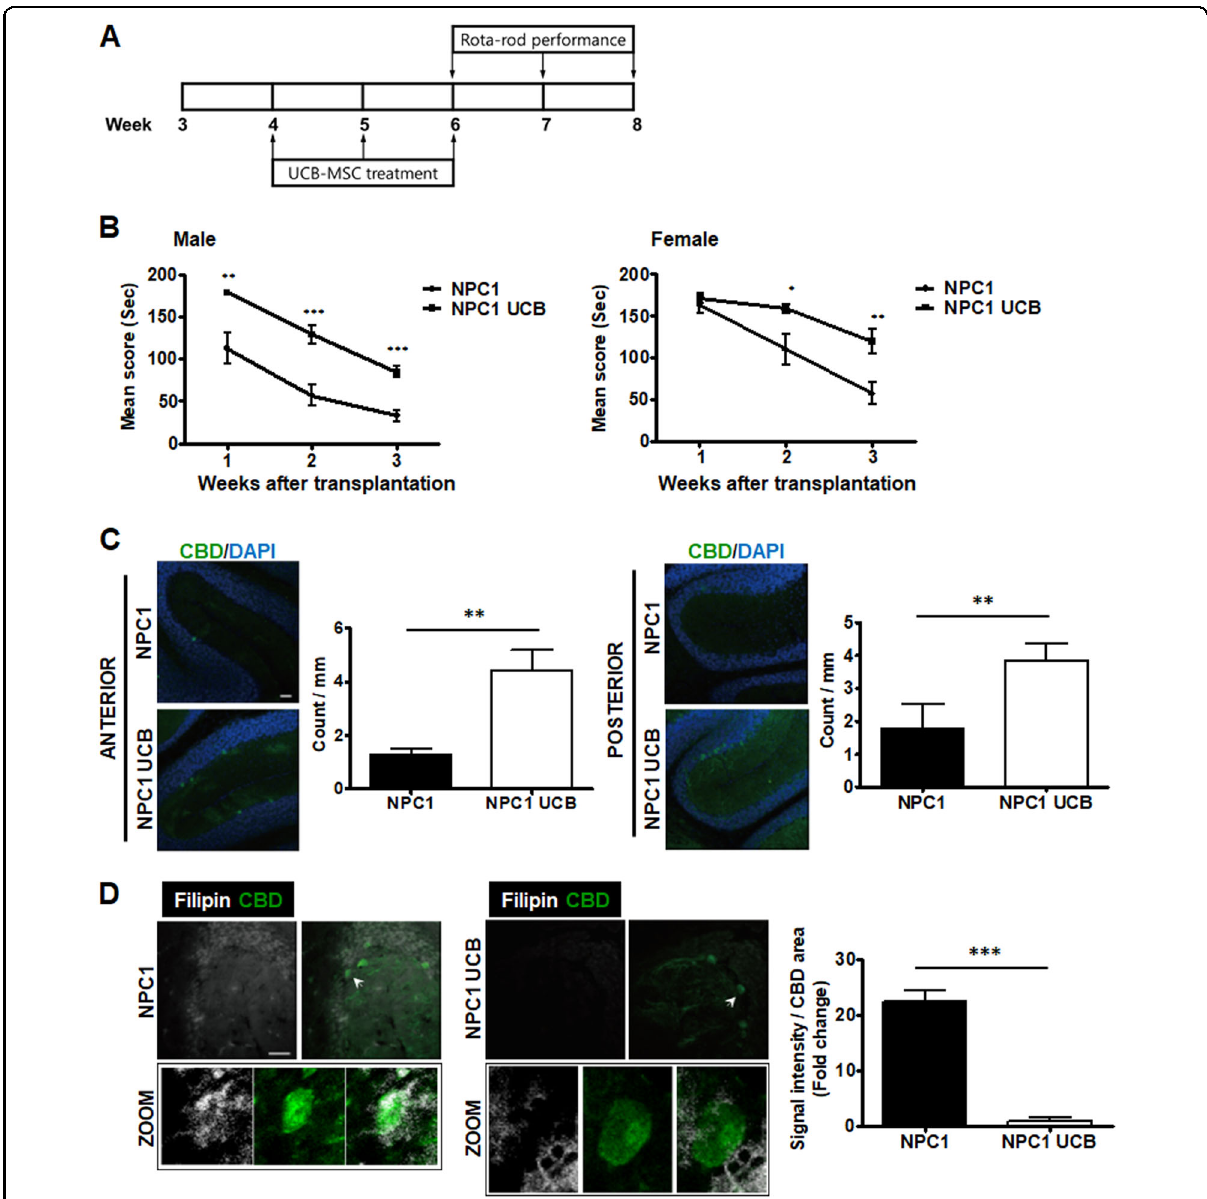
Fig. 2 Motor function and Purkinje cell survival rate in NPC1-mutant mice after intranasal administration of hUCB-MSCs. a Transplantation scheme for intranasal delivery of hUCB-MSCs in NPC1-mutant mice. b Compared with NPC1-mutant mice (NPC1), intranasal delivery of UCB-MSCs (NPC1-UCB) improves performance on the rotarod test in both males (NPC1 n = 9, NPC1-UCB n = 9) and females (NPC1 n = 6, NPC1-UCB n = 7). c Representative immunohistochemical images showing the distribution pattern of calbindin-positive Purkinje cells within the anterior and posterior regions of the cerebella of NPC1-mutant mice (NPC1) and hUCB-MSC administered NPC1-mutant mice (NPC1-UCB). The number of calbindin- expressing cells is indicated. Posterior region of the cerebella was also examined. d Cholesterol accumulation pattern in the Purkinje cells assessed by immunohistochemistry. NPC1-mutant mouse cerebella labeled with anti-calbindin show co-localization with the cholesterol detection marker fi lipin. hUCB-MSC treatment in NPC1-mutant mice results in less accumulation of fi lipin in the Purkinje cells. Arrowhead indicates magni fi ed Purkinje cells. All data represent the mean ± SD. Scale bars = 50 μ m ( a , b share the same scale bar; c , d share the same scale bar). * P < 0.05; ** P < 0.01; *** P <